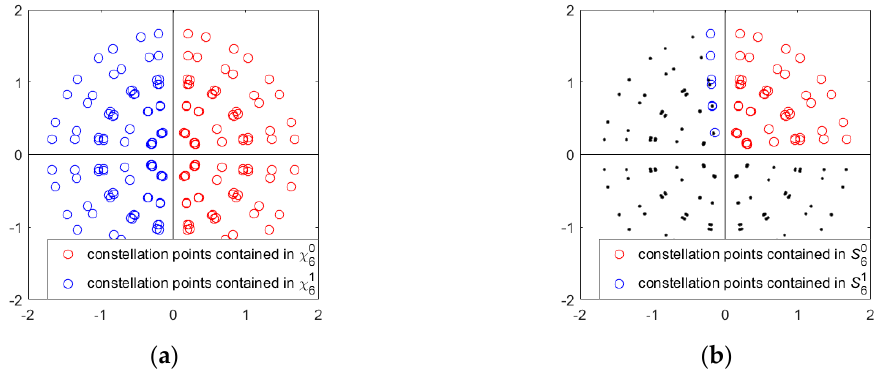
Figure 3. The subsets of ED comparison to calculate LLR( b 6 ) when the received symbol is in the first quadrant. ( a ) Subsets of Max-Log-MAP algorithm; ( b ) Subsets obtained after some constellation points are